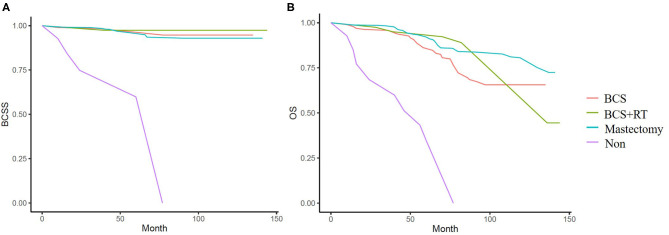
(A) Kaplan-Meier analyses of different local treatment on breast cancer specific survival (BCSS) in weighted samples. (B) Kaplan-Meier analyses of different local treatment on overall survival (OS) in weighted samples.